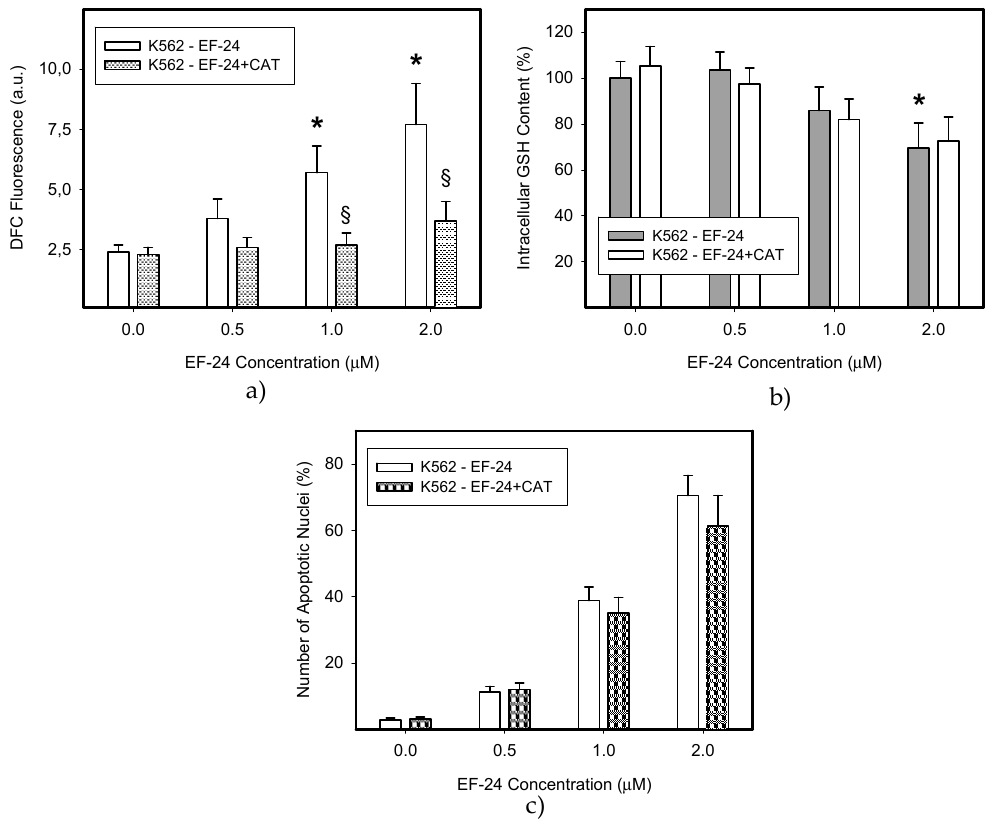
Figure 3. Effect of catalase (CAT) on EF-24-induced oxidative stress. Cells were treated with EF-24 or with EF-24 + CAT (50 U/mL), as indicated. The experimental points represent mean values from three replicate experiments, with standard deviations. ( a ) Effect of CAT on ROS production in EF-24 treated cells. After 3 h incubation, ROS production was determined using flow cytometry; * denotes significant change in ROS production ( p < 0.05) between control (untreated) K562 cells and cells treated with EF-24; § denotes significant change in ROS production ( p < 0.05) between EF-24-treated K562 cells and cells treated with EF-24 + CAT. ( b ) Effect of CAT on intracellular GSH level in EF-24 treated cells. After 6 h incubation, the intracellular content of GSH was determined using LC/MS/MS analysis; * denotes significant change in intracellular level of GSH ( p < 0.05) between control (untreated) K562 cells and cells treated with EF-24. ( c ) Effect of CAT on nuclear morphology in EF-24-treated cells. After 24 h, cells were stained using Hoechst33342, and nuclear morphology was examined using fluorescence microscopy.